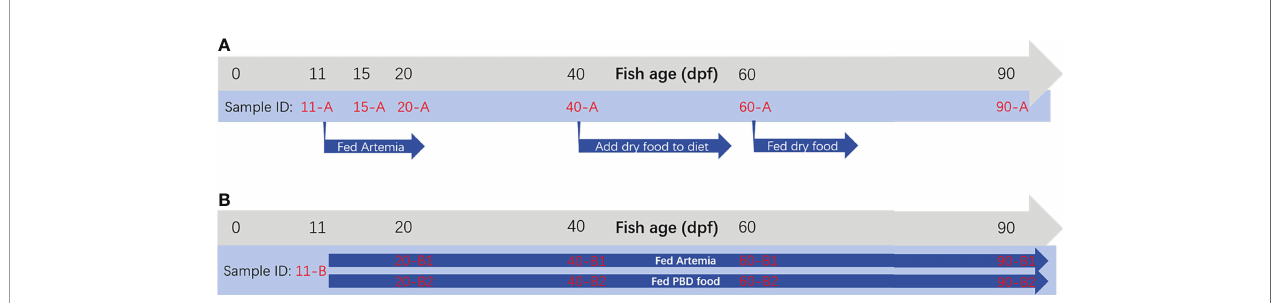
FIGURE 1 | Experimental design. (A) Experiment I studied the effect of diet transition on the gut microbiota of tilapia. (B) Experiment II studied the effects of diet on the intestinal microbiota of tilapia after the fi rst feeding. (A) 11-A, 15-A, 20-A, 40-A, 60-A and 90-A: tilapia at 11, 15, 20, 40, 60 and 90 dpf in Experiment I. (B) 11-B: tilapia at 11 dpf in Experiment II. 20-B1, 40-B1, 60-B1, and 90-B1: tilapia at 20, 40, 60 and 90 dpf fed Artemia in Experiment II. 20-B2, 40-B2, 60-B2, and 90-B2: tilapia at 20, 40, 60 and 90 dpf fed PBD food in Experiment II. The same